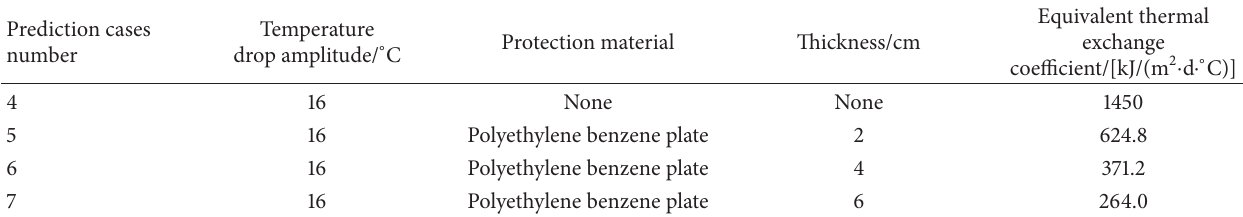
Table 5: Temperature and thermal stress prediction cases at abnormal